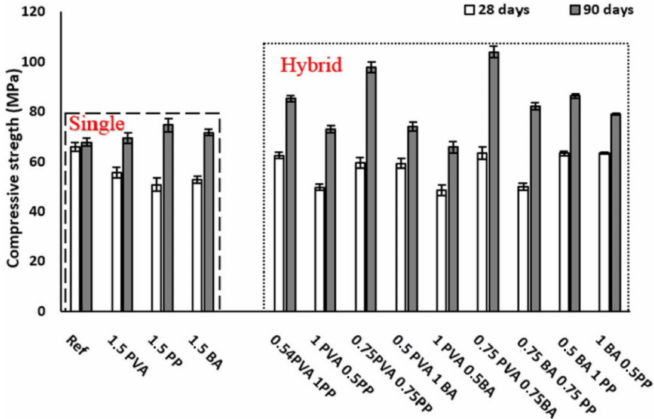
Figure 9. The effects of freeze–thaw cycles on the compressive strength [65]. Adapted with permission from [65], copyright 2020